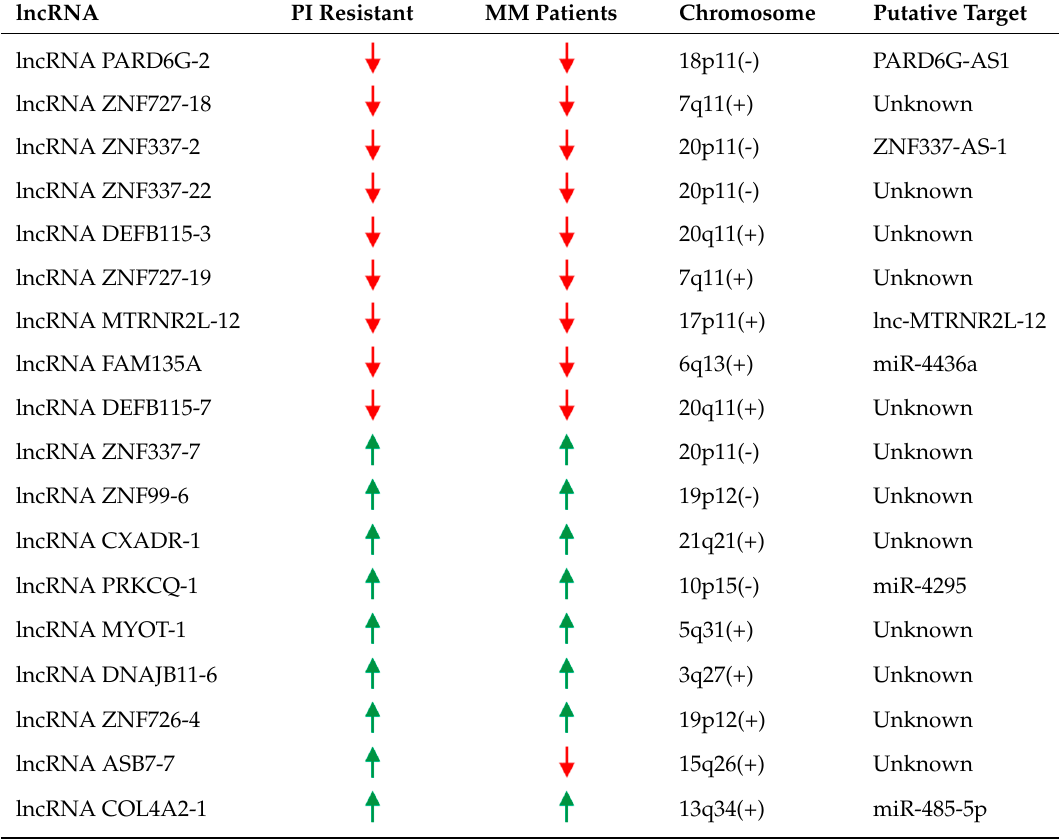
Table 3. Shown are lncRNAs upregulated (green up arrow) or downregulated (red down arrow) in PI ‐ resistant MM cells and MM tumor cells. Chromosomal location, strand type, and putative gene or ncRNA targets are also shown based upon searches using http://lncipedia.org/ and